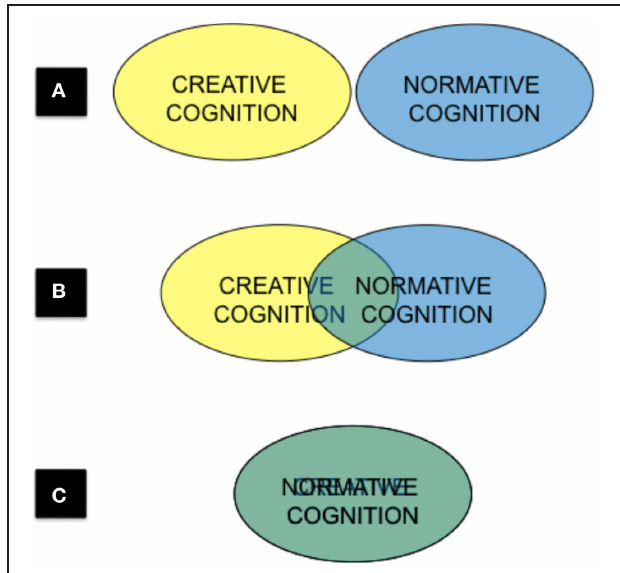
FIGURE 1 | Three conceptualizations of the relationship between creative and normative cognition: (A) mutually exclusive, (B) partially overlapping, (C)